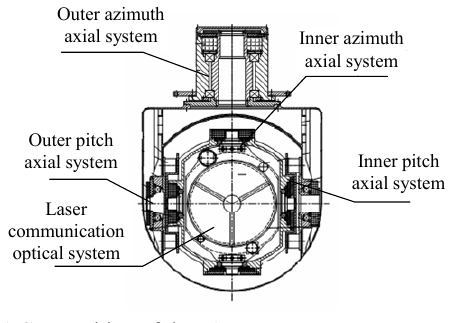
Fig. 1 Composition of the PAT